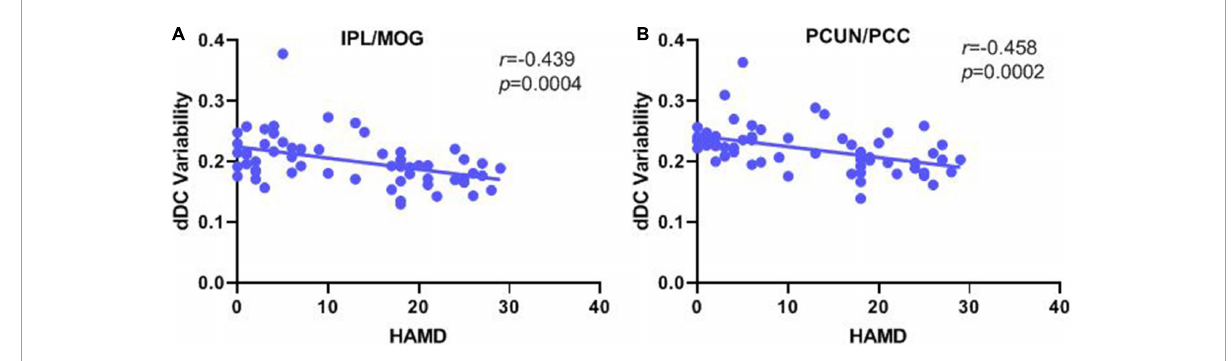
FIGURE3 Correlation analysis of the dDC variability with manic/depressive symptoms in all patients with bipolar disorder. (A) Pearson’s correlation between the altered dDC variability in the IPL/MOG with HAMD score. (B) Pearson’s correlation between the altered dDC variability in PCUN/PCC with the HAMD score. dDC, dynamical degree centrality; BD, bipolar depression; BM, bipolar mania; BE, bipolar euthymia; HCs, healthy controls; IPL/MOG, inferior parietal lobule/middle occipital gyrus; PCUN/PCC, precuneus/posterior cingulate cortex.